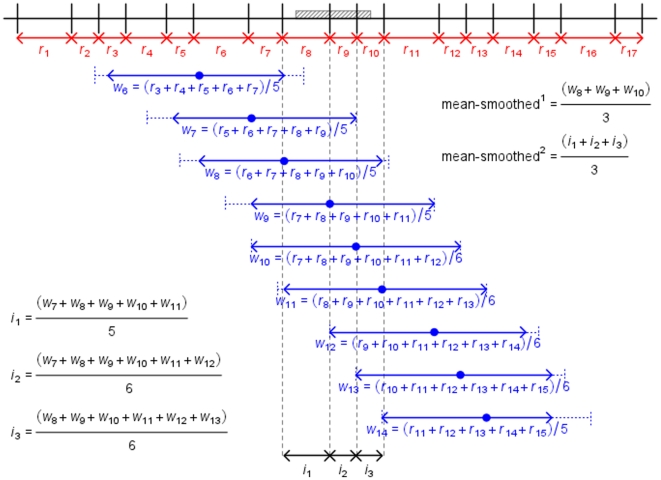
Methodologies used to generate smoothed recombination rates.Representation of methods used to calculate smoothed recombination rates (method 4.2.4). Note that this diagram is for descriptive purposes only and is not to scale. For simplicity, only calculations for mean rates are shown. The grey region is a gene. Vertical black lines are SNP markers. In red are recombination rates between pairs of neighbouring markers (rx). Dashed blue lines represent 1 Mb windows either side of a focal SNP. Solid blue arrows represent all intervals within this window, over which recombination rates are averaged (wx, averaged-smoothed1). For three intervals, averages of all window averages covering the interval are shown (ix, average-smoothed2).